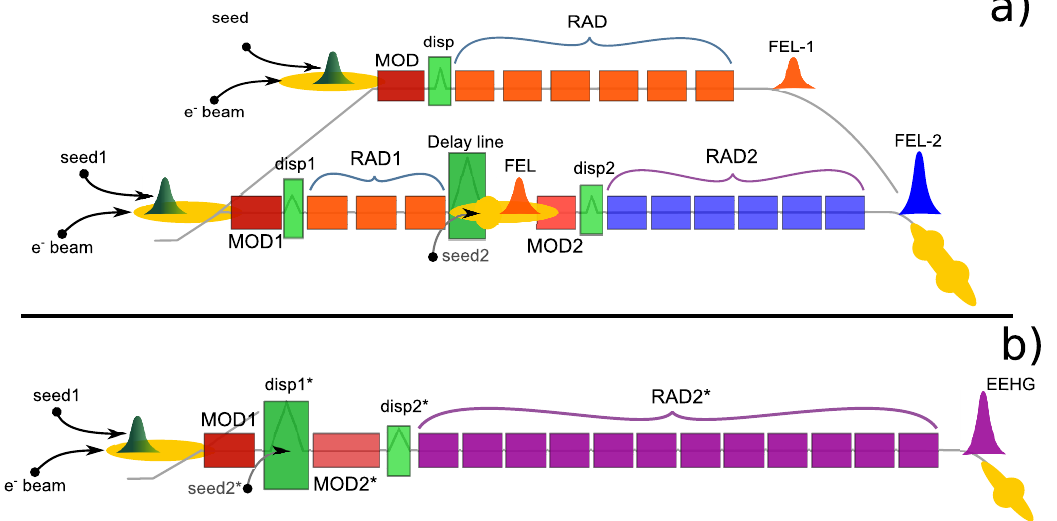
Figure 1. ( a ) Current FERMI layout. The top part shows the FEL-1 beamline based on the standard HGHG setup; see text for details. The seed laser, i.e., the third harmonic of a Ti:SA laser at 260 nm or an OPA, interacts with the electron bunch in the modulator (MOD). The dispersive section (disp) generates a micro-bunched e-beam that emits coherent light at one of the seed harmonics in the radiator (RAD). The beamline can produce stable FEL pulses at the GW power level and wavelengths down to 20 nm using six radiator sections with an individual length of 2.4 m. The bottom part shows the FEL-2 beamline, which is based on a two-stage HGHG cascade. In the first radiator (RAD1), coherent light is produced at a wavelength of around 20 nm (~13th harmonic of the seed). A strong chicane (delay line) is then used to delay the e-beam with respect to this light and seed a fresh portion of the electron bunch in the second modulator (MOD2). The second radiator (RAD2) then emits pulses at a harmonic (~4) of the first stage, reaching saturation at a GW power level and wavelengths around 5 nm or shorter. Currently, six radiator sections are installed, while there is space for an additional two. This beamline (with minor component modifications) will be used for the first EEHG experiment at FERMI. ( b ) Advanced EEHG layout under consideration at FERMI. The beamline will have a more compact design and up to 12 radiator sections, to ensure saturation of the output power at wavelengths around 3 nm or shorter; see text for details.